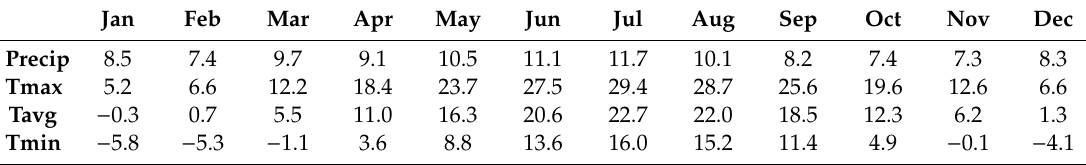
Table 1. Monthly averages of total precipitation (Precip; cm), maximum temperature (Tmax; ◦ C), minimum temperature (Tmin; ◦ C), and average temperature (Tavg; ◦ C) averaged across eighteen observation locations in West Virginia, USA (Table 2) between 1900 and